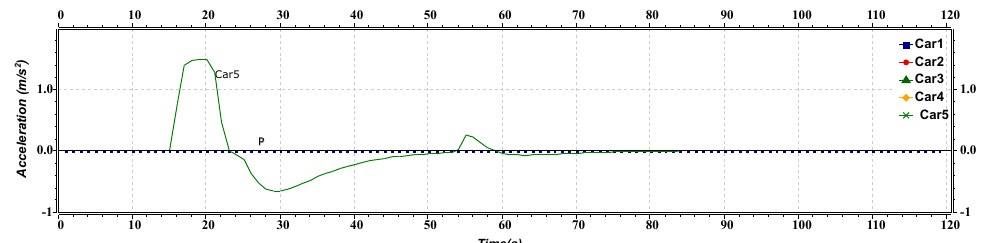
Figure 10. Acceleration versus time graph of joining maneuver.